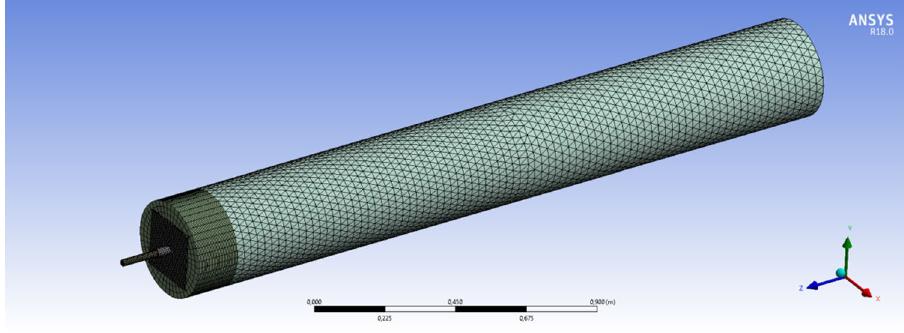
Fig. 4 An example of a finite element model for an analyzed case